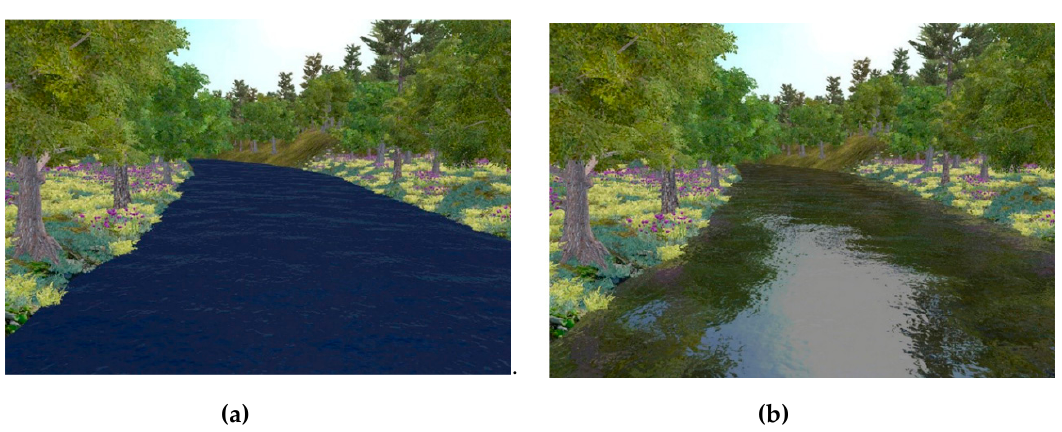
Figure 4. 3D VR scene of the fluvial reach ( a ) without and ( b ) with the light refraction and the water transparency in depth. Table 1. Final questionnaire on students’ satisfaction.